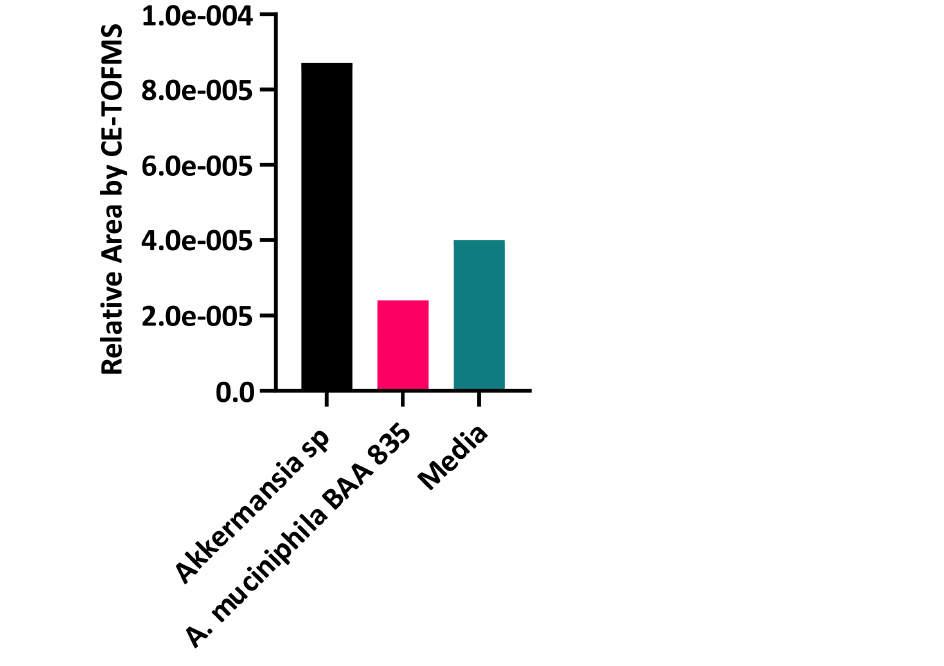
Figure 3. Sample comparison of CE-TOFMS relative peak areas of Agmatine. Akkermansia sp. DSM 33459 and A. muciniphila BAA-835 supernatants were collected after 24 h of growth and analyzed by CE-TOF-MS.